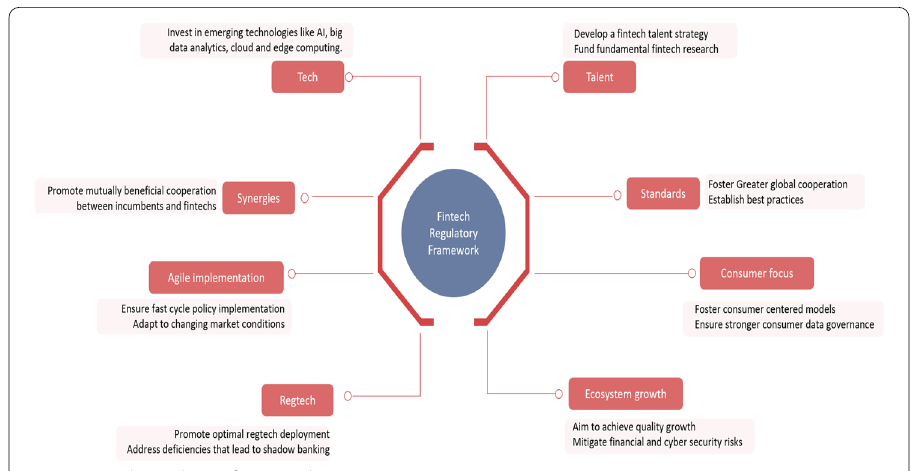
Fig. 2 Fintech regulatory